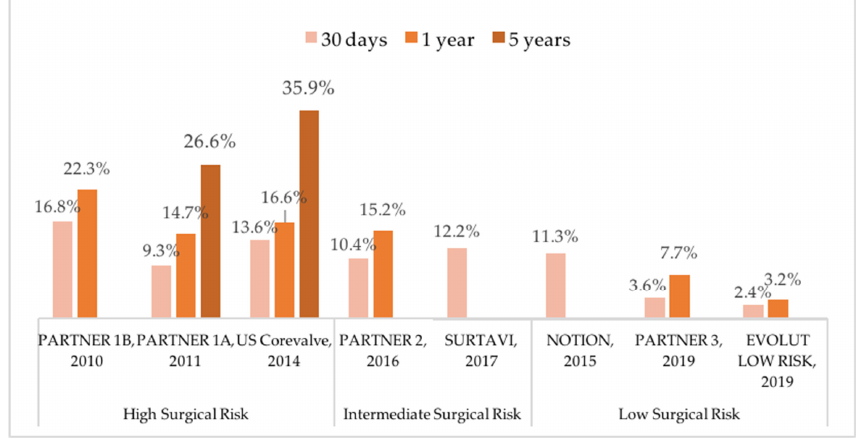
Figure 5. Reported incidences of life-threatening or disabling bleeding after transcatheter aortic valve replacement in pivot trials. NOTION: Nordic Aortic Valve Intervention Trial; PARTNER: Placement of Aortic Transcatheter Valve; SURTAVI: Safety and Efficacy Study of the Medtronic Corevalve© System in the Treatment of Severe, Symptomatic Aortic Stenosis in Intermediate Risk Subjects Who Need Aortic Valve Replacement.